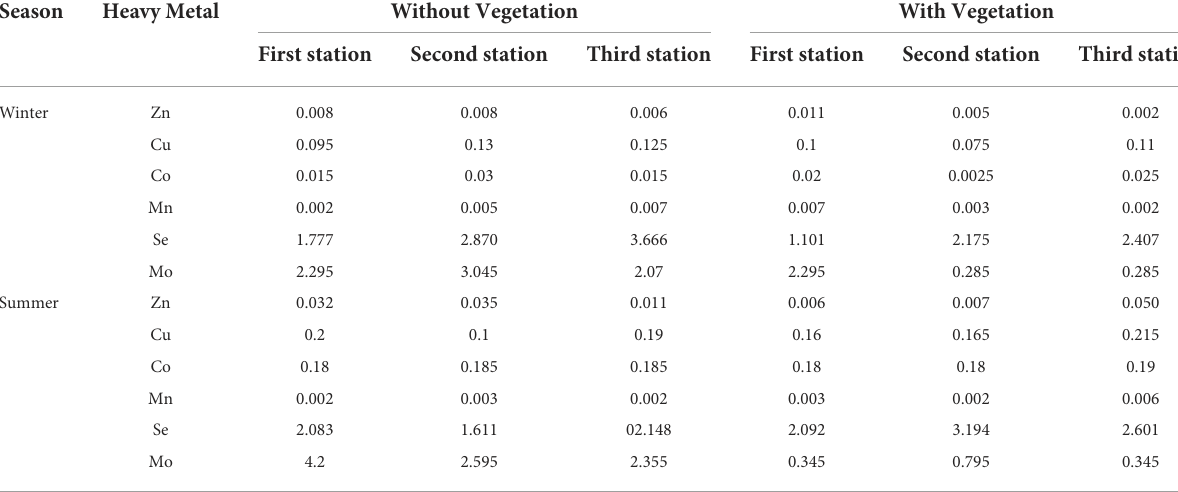
TABLE 6 The ecological risk (ER) of heavy metals in coastal Shadegan soils (winter and summer of